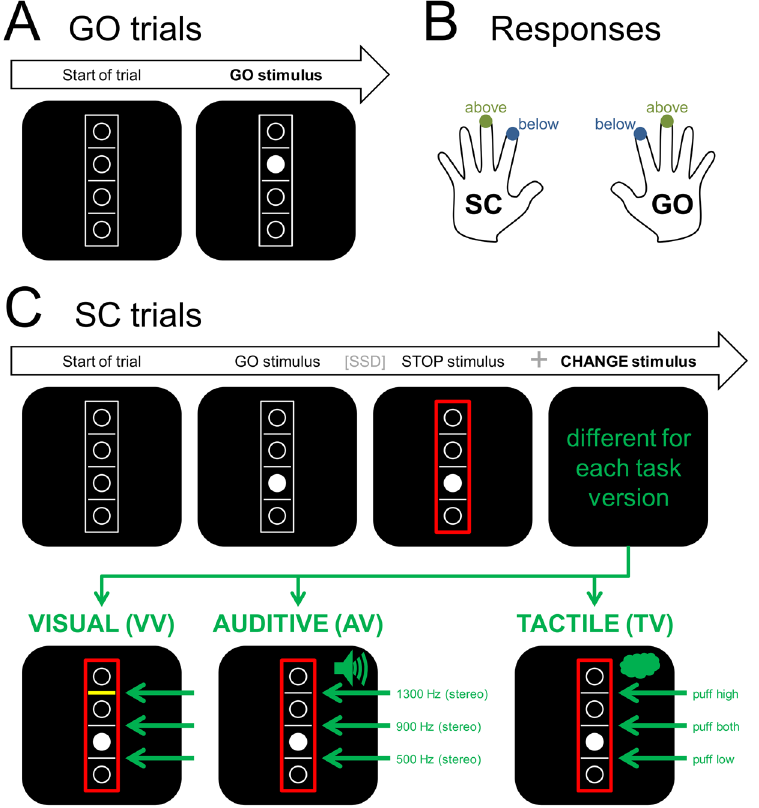
Figure 1. Illustration of the Stop change task and its variations. Despite all task version differences, the instructions were conceptually comparable and always required the subjects to judge the location of the target (white filled circle) in relation to either the middle reference line (GO trials) or to the reference line indicated by the CHANGE stimulus (SC trials). ( A ) The GO trial was identical for all task versions: After the empty visual array was presented for 250 ms, the target stimulus (white filled circle) appeared and stayed on the screen until the first given response. ( B ) Illustration of the required responses. The right hand should be used to respond in GO trials, while the left hand should be used in Stop-Change (SC) trials. To indicate that the target was located below the respective reference line, the index fingers had to be used. To indicate that the target was located above the respective reference line, the middle fingers had to be used. ( C ) Illustration of a SC trial. All SC trials started like regular GO trials, but after a variable stop signal delay (SSD), a stop signal (red frame) was introduced. The CHANGE signal was presented simultaneously. Participants always had to judge the target’s position relative to the reference line indicated by the CHANGE signal. In the visual condition (see bottom left), a yellow line would appear at one of the three line’s locations to assign a new reference line (visual stimulus illustrated for the upper line; green arrows point to the three possible positions). In the auditive task version, a binaural high (1300 Hz) tone coded for the high reference line, a medium tone (900 Hz) for the middle line and a low tone (500 Hz) for the low line. In the tactile task version, a high air puff (top of sternum) coded for the high reference line, a low puff (right below belly button) coded for the low line and a combination of both puffs coded for the middle line. Please note that the green symbols and illustrations were only added to facilitate the reader’s understanding but were not shown to the